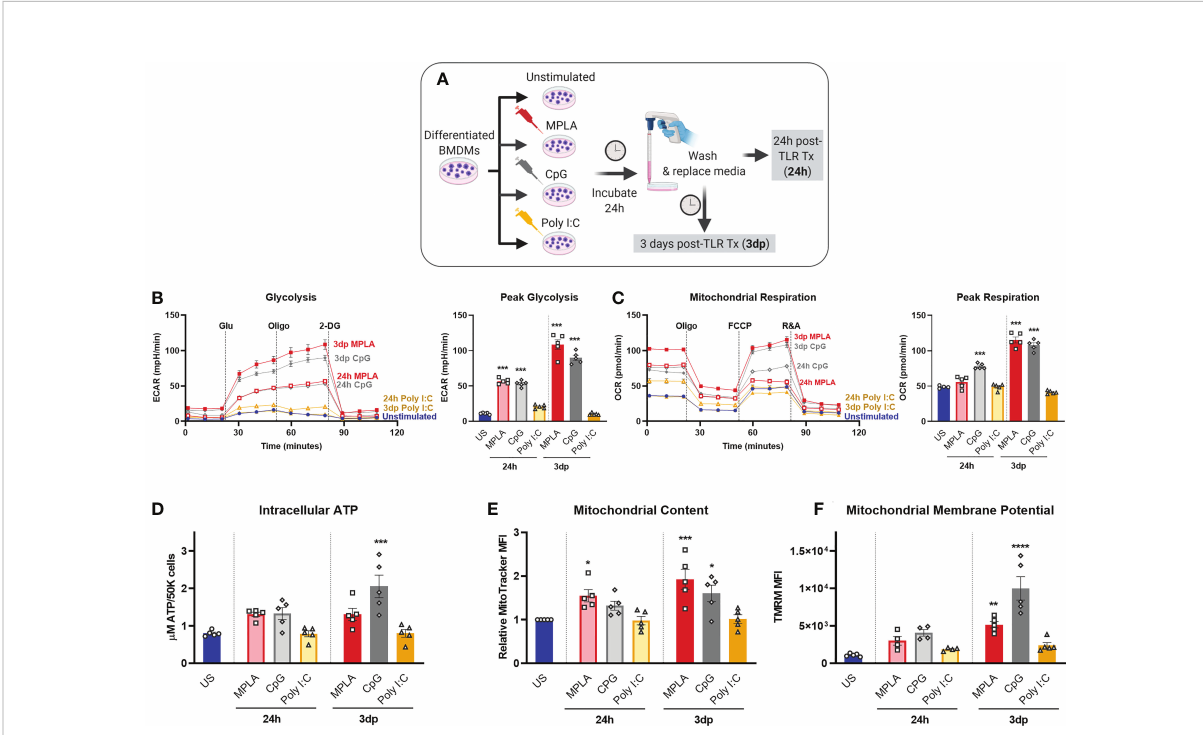
FIGURE 4 MyD88-selective CpG, but not TRIF-selective Poly I:C, triggers macrophage metabolic reprogramming. (A) Differentiated BMDMs were treated with MPLA (1 µg/mL), CpG (1 µg/mL), Poly I:C (10 µg/mL) or left unstimulated as controls for 24h. BMDMs were either washed and immediately assayed (24h) or rested for 3 days prior to assay (3dp). (B) Glycolysis stress test was performed and extracellular acidi fi cation rate (ECAR) was measured by Seahorse Xfe96 (left); peak glycolysis was analyzed (right). (C) Mitochondrial stress test of BMDMs was performed and oxygen consumption rate (OCR) was measured (left); peak respiration was analyzed (right). (D) BMDMs (5X10 4 ) were washed, lysed, and ATP content was measured. (E) Mitochondrial content was assessed using MitoTracker Green staining and (F) mitochondrial membrane potential was assessed using TMRM staining. Data are shown as mean ± SEM, n = 4-5/group *p < 0.05, **p < 0.01, ***p < 0.001, ****p < 0.0001 by ANOVA followed by Dunnett ’ s post-hoc multiple comparison